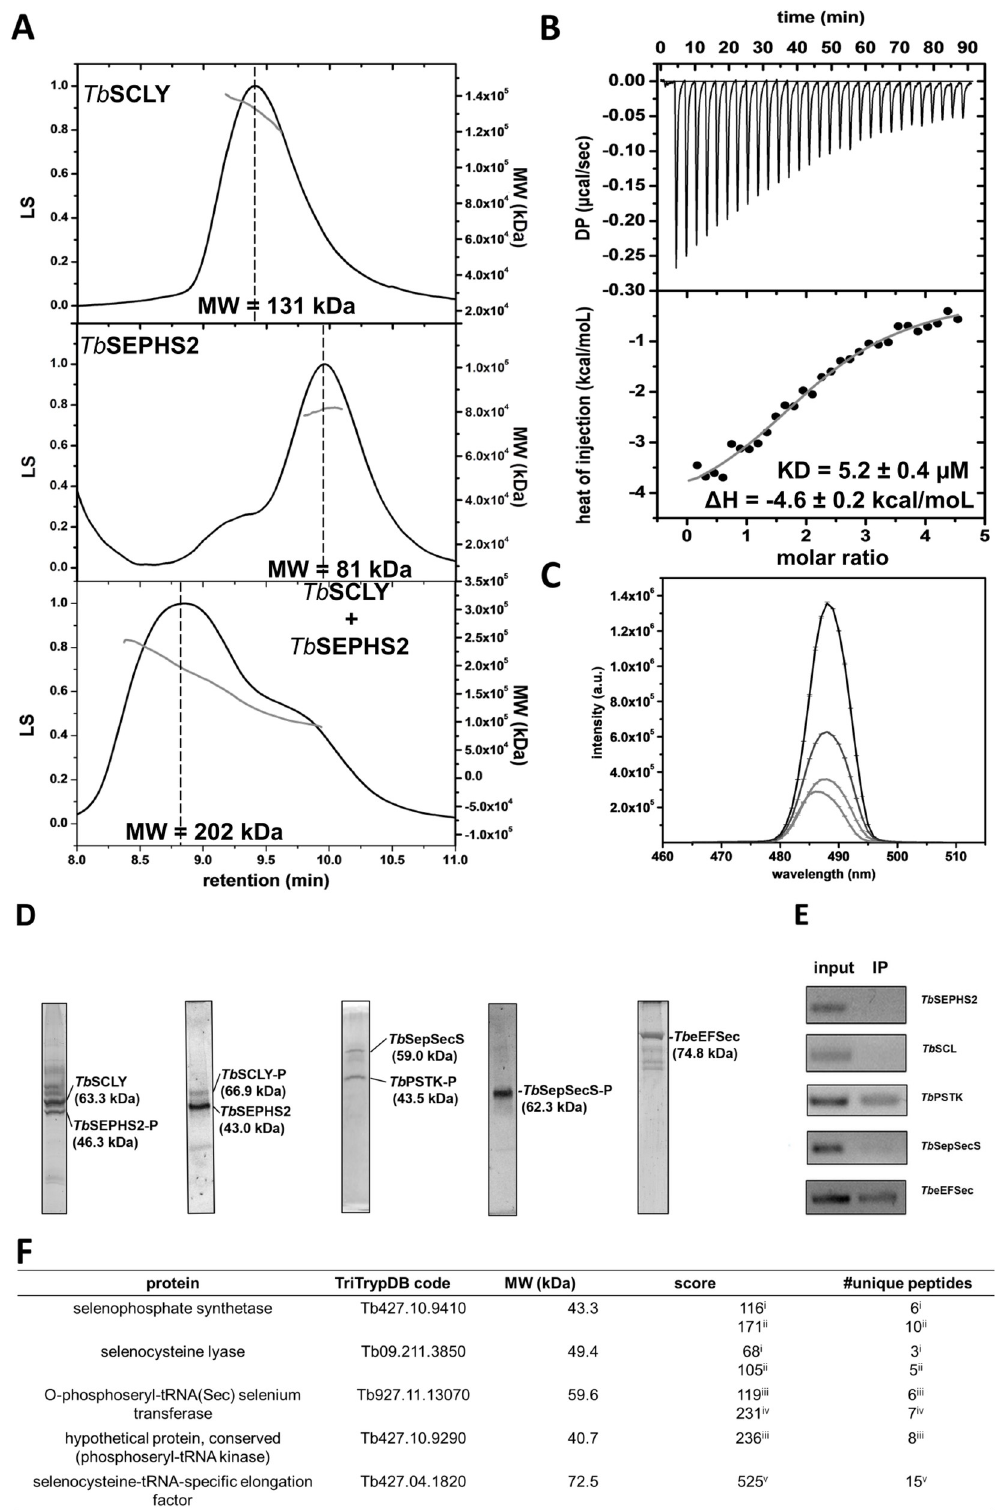
Fig 3. Interaction between selenophosphate synthetase and selenocysteine lyase. A- SEC-MALS profiles for Tb SCLY (40 μ M; theoretical molecular weight (dimer) = 127 kDa), Tb SEPHS2 (40 μ M; theoretical molecular weight (dimer) =